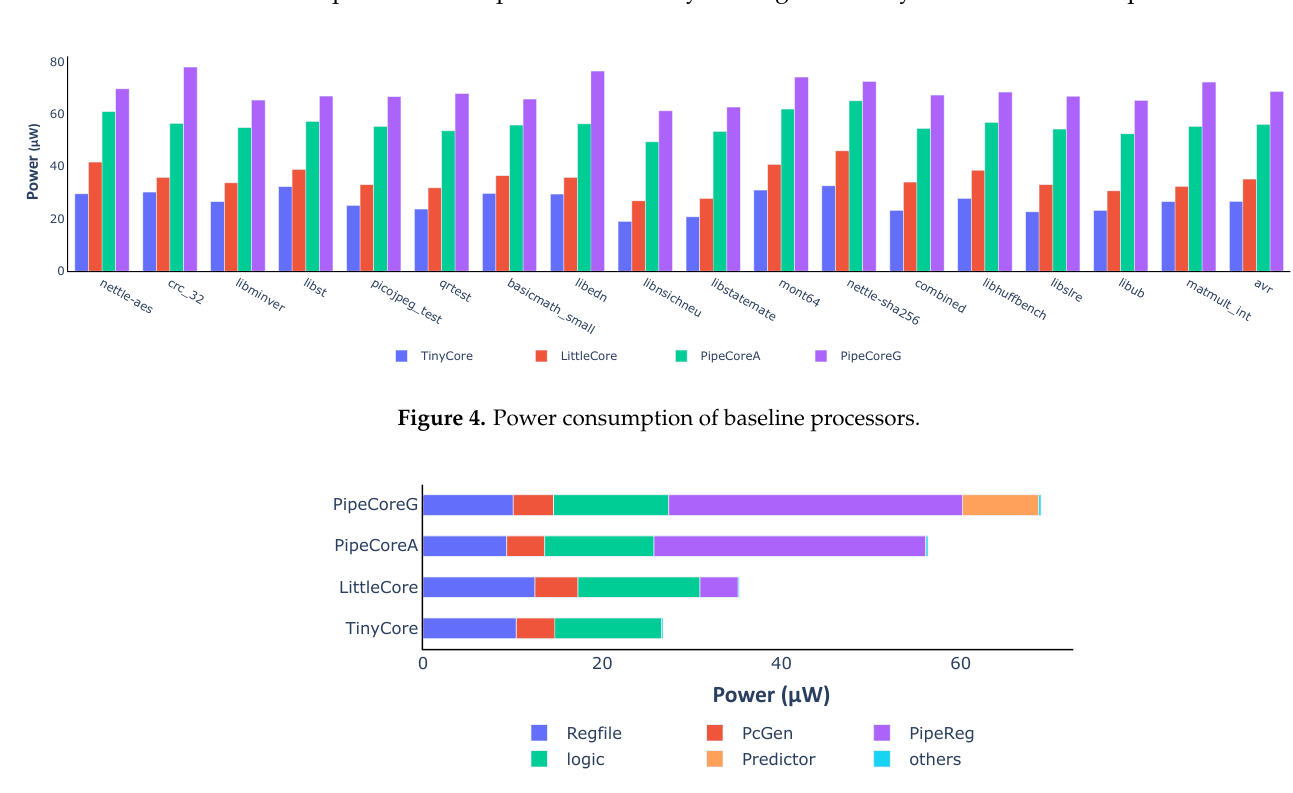
Figure 5. Average power consumption and distribution of baseline processors.